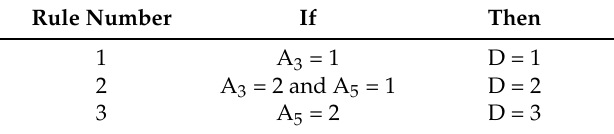
Table 5. Rules involved in the operation of RWHs.